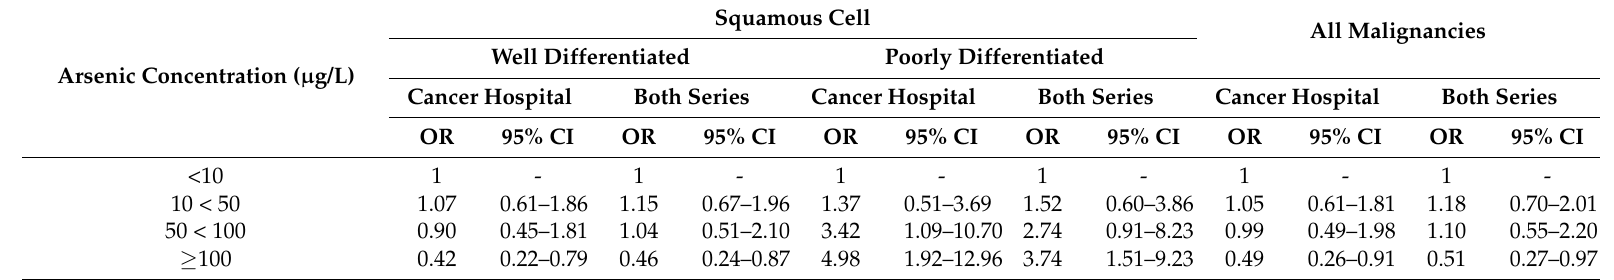
Table 3. Logistic regression * for well differentiated squamous cell, poorly differentiated squamous cell and all malignancies by arsenic concentration with benign renal lesions as the comparison